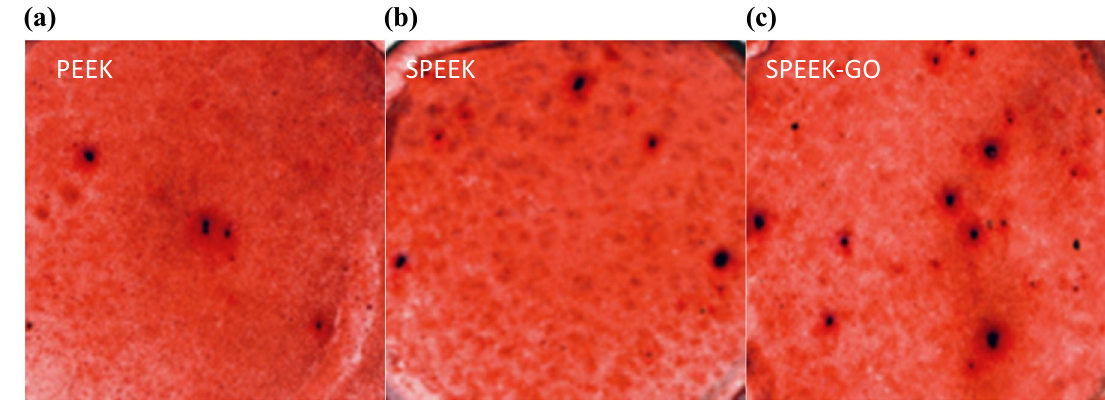
Fig. 14 ARS of various samples ( a ) PEEK; ( b ) SPEEK; ( c ) SPEEK-GO. The SPEEK-GO group had the most calcium nodules